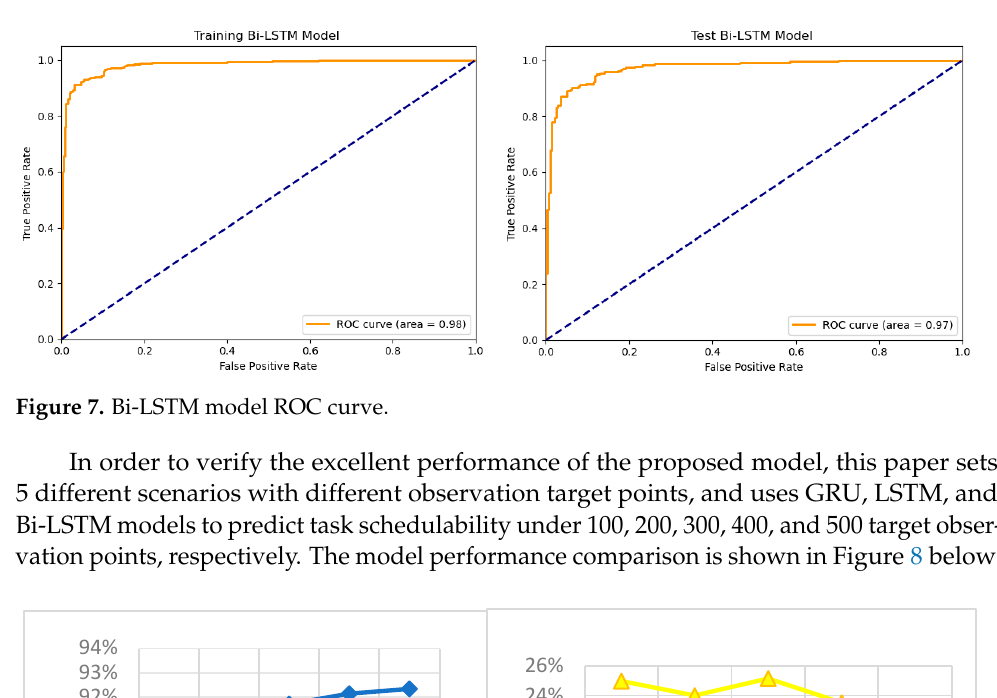
Figure 7. Bi-LSTM model ROC curve.